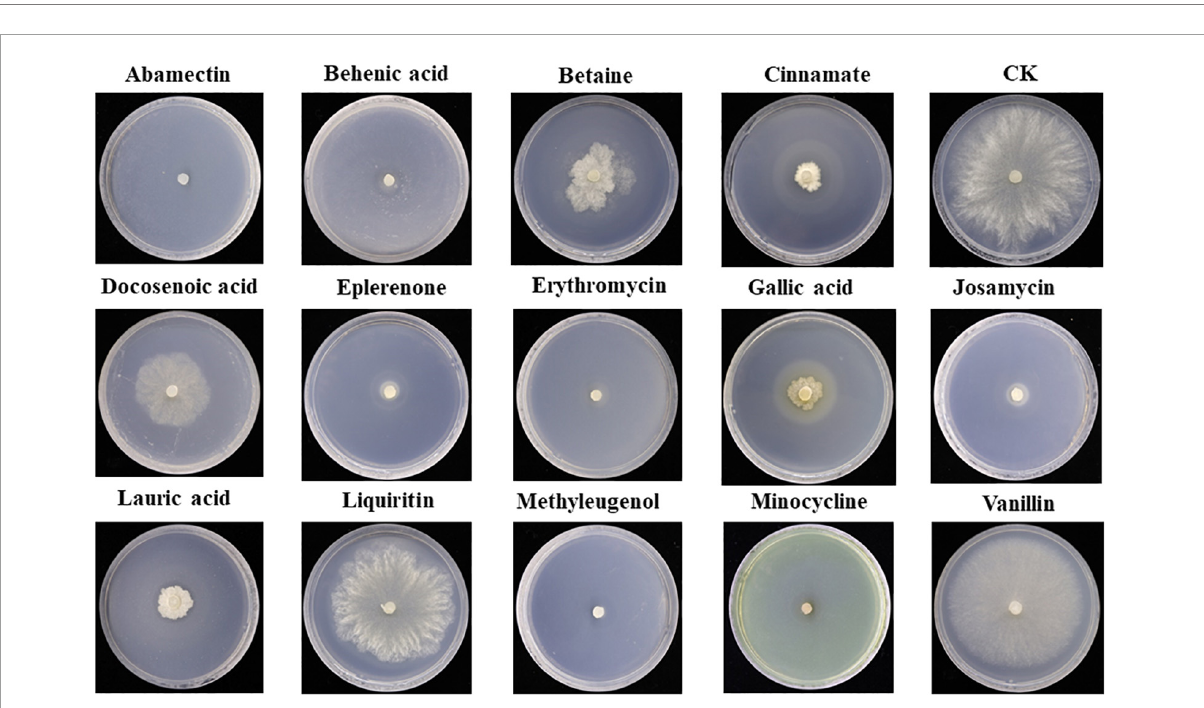
FIGURE7 Antifungal activity of major differential metabolites against Sclerotinia asari.